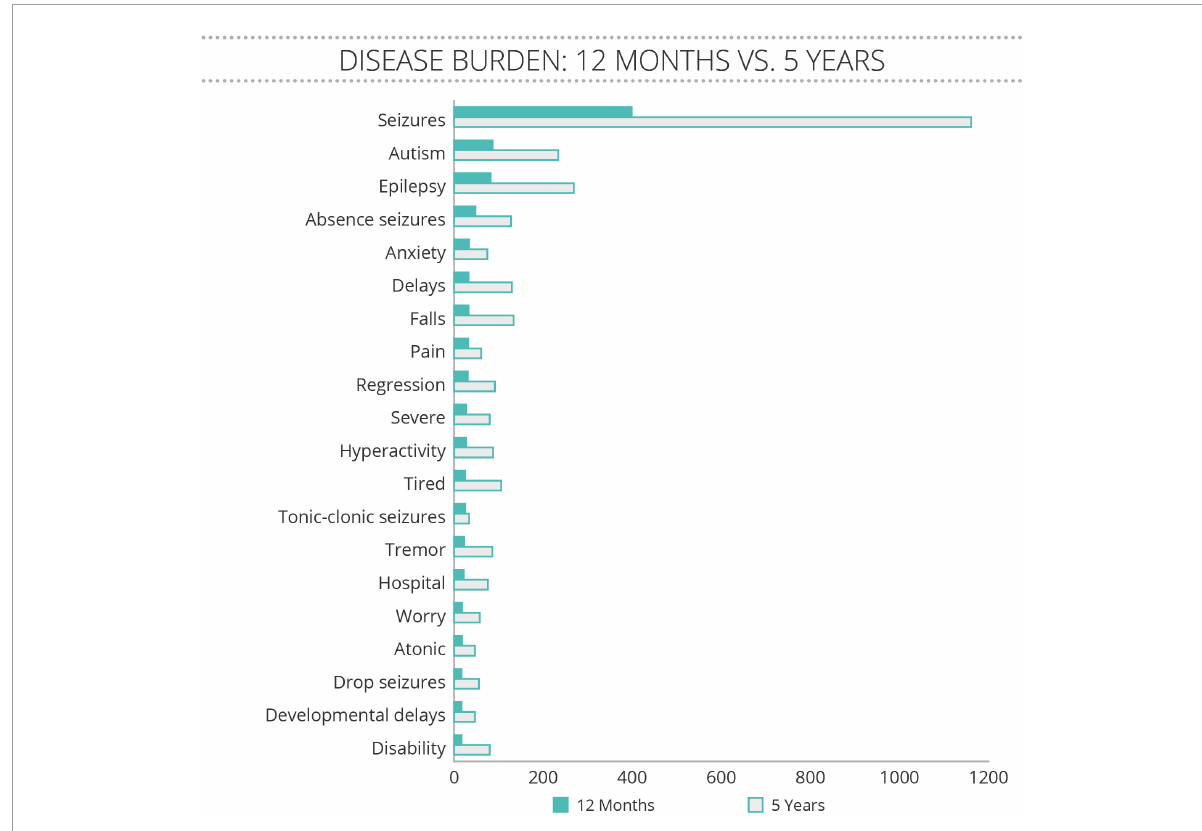
FIGURE1 Disease Concepts most often mentioned spontaneously by family members of people with SLC6A1 Neurodevelopmental Disorder (SLC6A1-NDD). With permission from the administrators, TREND Community gathered all postings between January 2016 to February 2021 from a private social media group anonymously, and analyzed them for key terms. The number of mentions of concepts related to disease burden were analyzed for a 12 month period (February 2020 to February 2021) of conversations, and all of the conversations. The 20 terms that were most often mentioned are listed, with very little change in frequency between the 12 month period and the